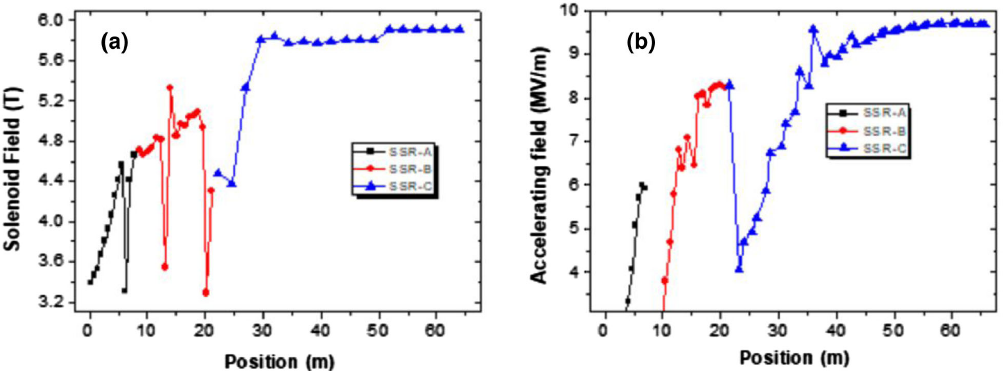
FIG. 34. (a) Magnetic fields of the superconducting solenoids in the superconducting section of the MEHIPA linac, and (b) cavity accelerating field calculated over the effective cavity length ( β